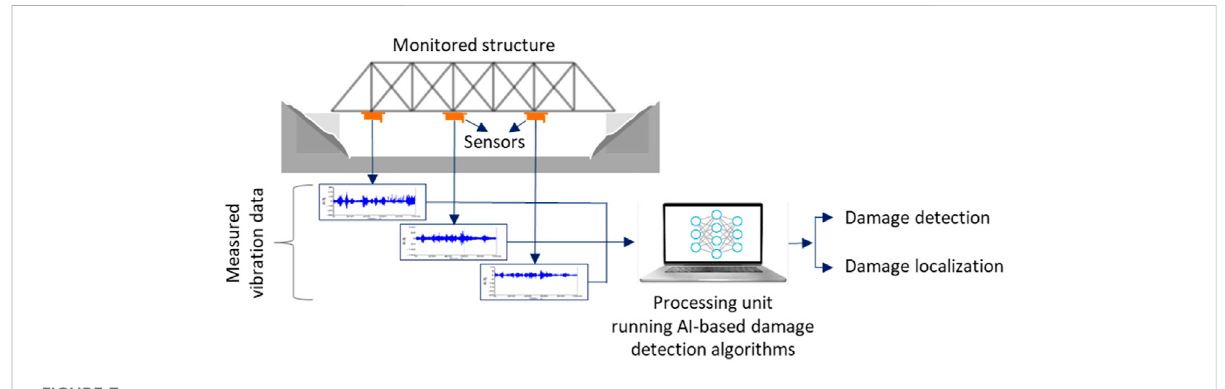
FIGURE 7 A general framework for vibration-based damage detection